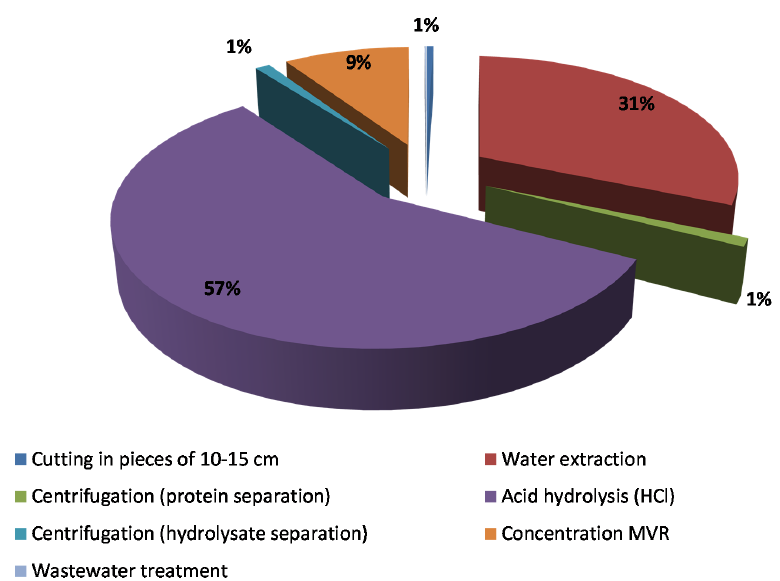
Figure 3. CO 2 emission percentages (on a total basis) for the industrial phases of chemically-produced protein hydrolysate from leather waste.